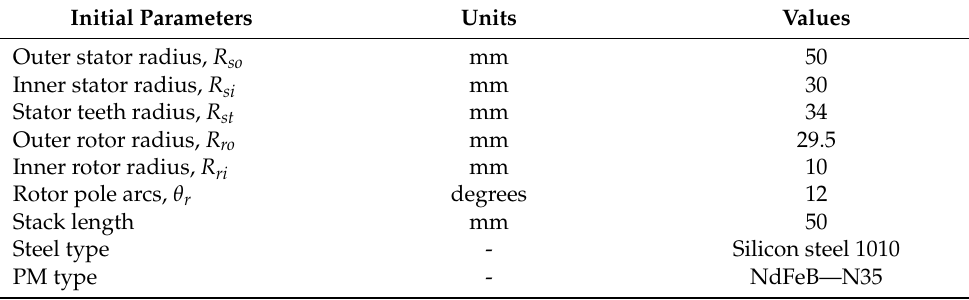
Table 1. Initial design specifications and electrical constraints of the multi-tooth